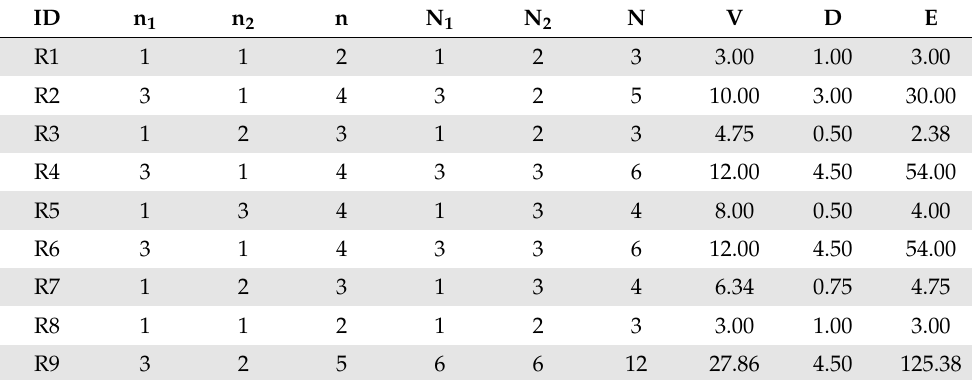
Table A4. Metrics calculations for CRL .